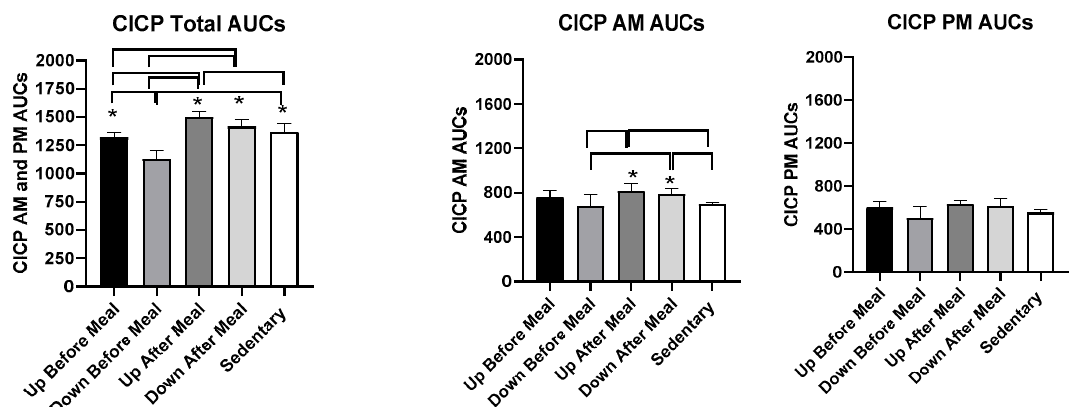
Figure 3. Postprandial CICP areas under the curve (AUCs) after the morning and afternoon meals with the two AUCs combined (left) and the morning (center) and afternoon (right) AUCs shown individually. Greatest increases in CICP AUCs were seen in the two exercise-after-meals trials (UAM and DAM) relative to sedentary trials, both for combined AUCs (left) and morning postprandial AUCs (center). Only UAM CICP AUC remained higher than the SED trial after the afternoon meal. Combined CICP AUC in the UBM trial also was significantly higher than in the DBM trial. * indicates significant difference relative to groups marked by the overhead bracket